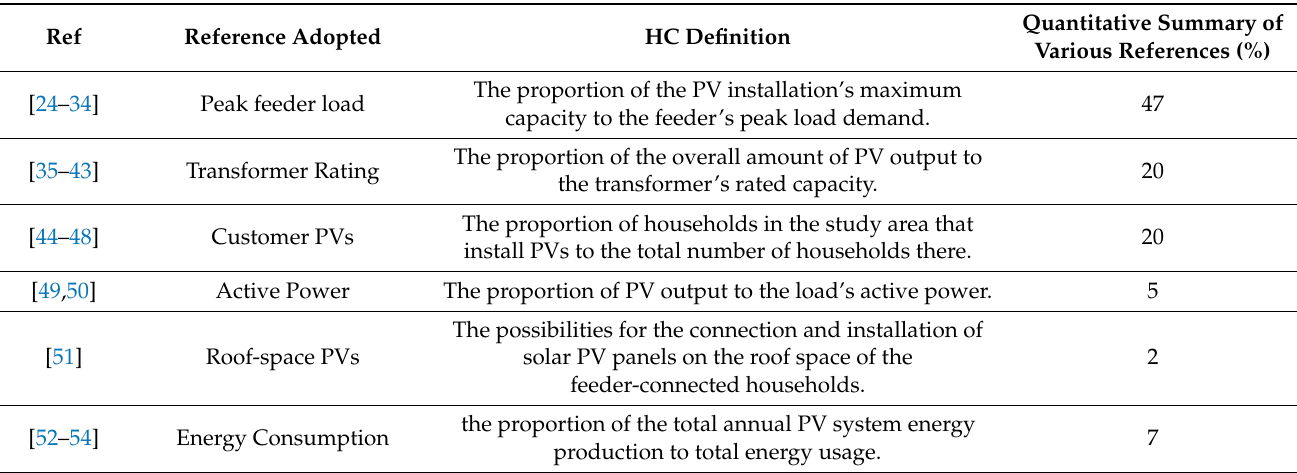
Table 1. Definitions of HC based on different references adopted for defining HC